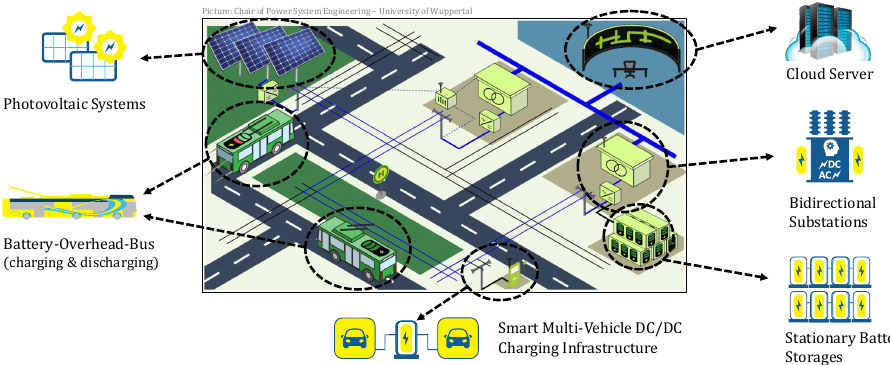
Figure 1. Schematic Concept of the STS in the City of